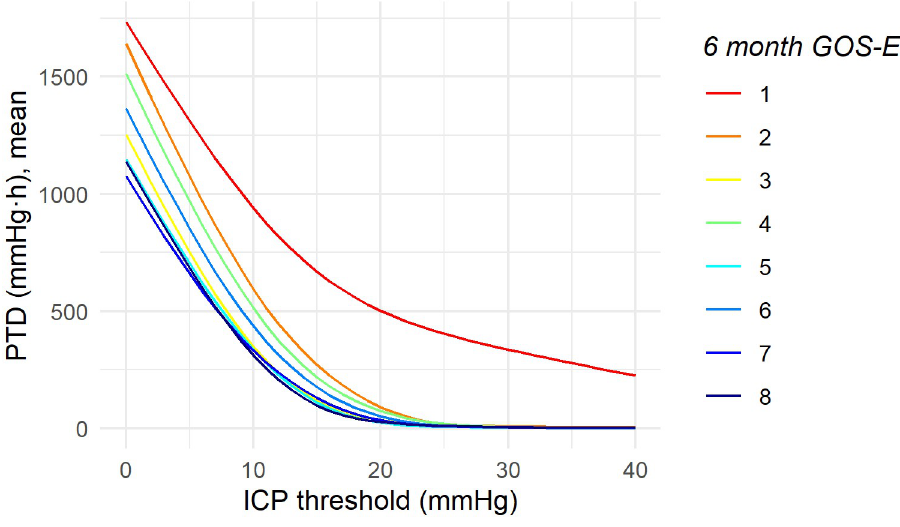
Fig 6. Total pressure and time dose (PTD) above ICP thresholds stratified by outcome at 6 months. The group mean PTD was higher for patients who had died within 6 months post injury, while the mean doses were similar for GOS-E 3 to 8